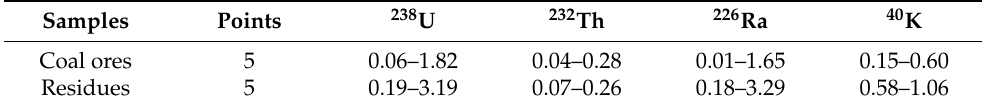
Table 2. Radioactivity concentrations in coal ores and residues (Bq/g).